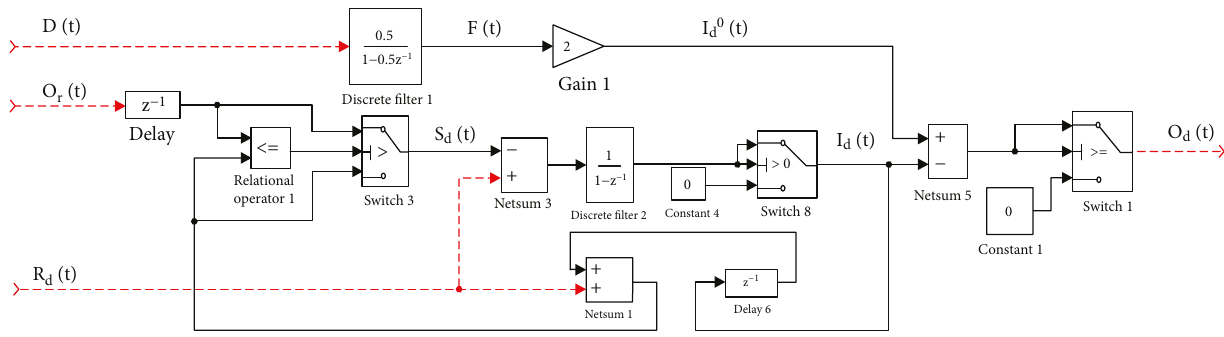
Figure 3: The block diagram of the inventory system of distribution